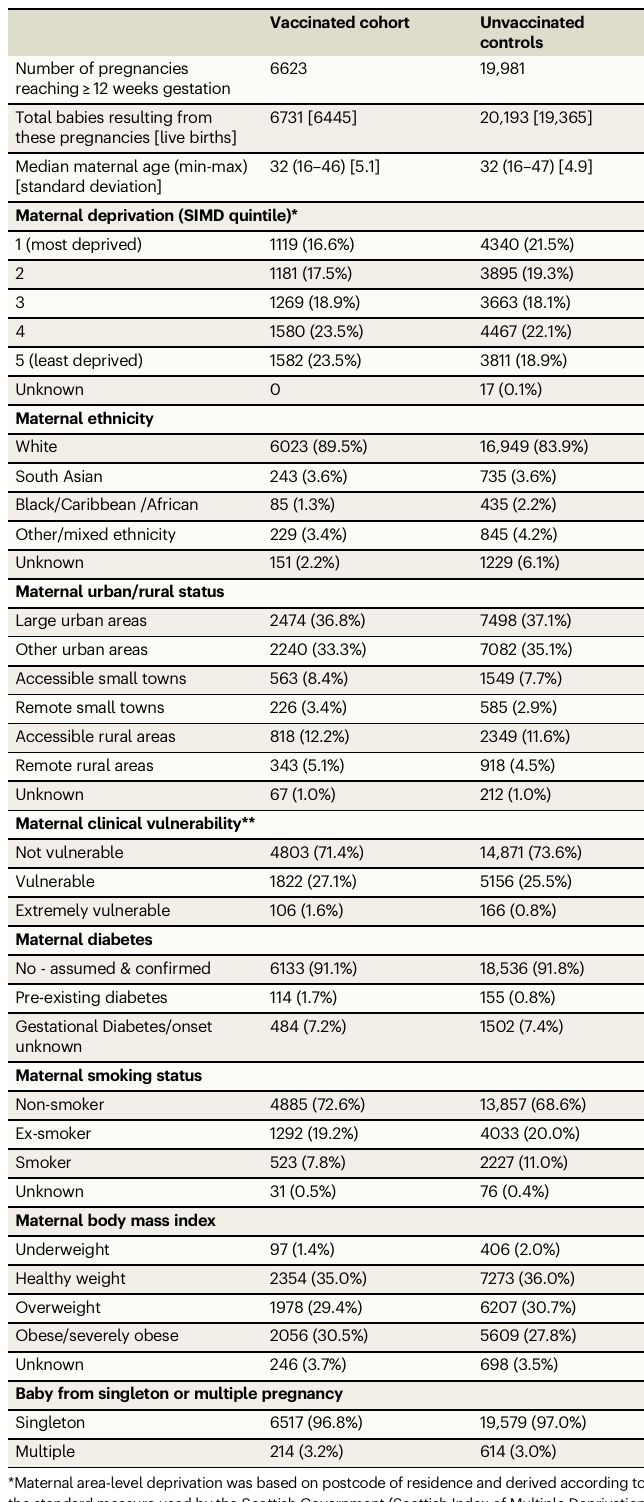
Table 1 | Key sociodemographic and clinical characteristics of vaccinated and control groups Vaccinated